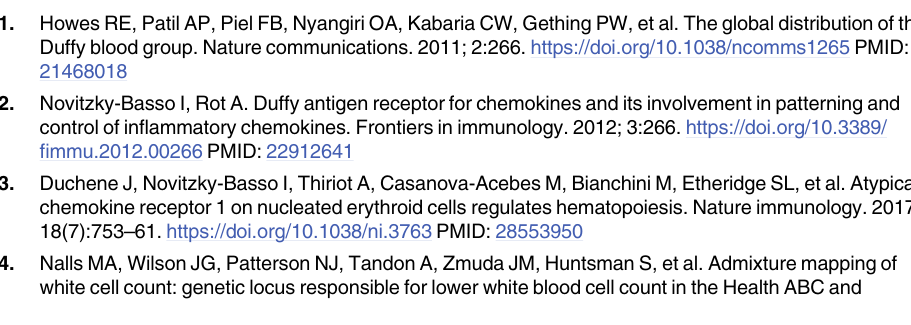
S5 Table. CD8+ T cell profiles of study participants. Data is represented as median (IQR). CD8+ T cell data is presented as a percentage of the lymphocyte gate. Phenotype, functional and proliferation data is presented as a percentage of CD8+ T cells. � ANC associations were calculated from 18 HIV+ participants (ANC was not available for 1 participant). Abbrevia- tions: DARC, Duffy Antigen Receptor for Chemokines; IQR, Interquartile range; n,